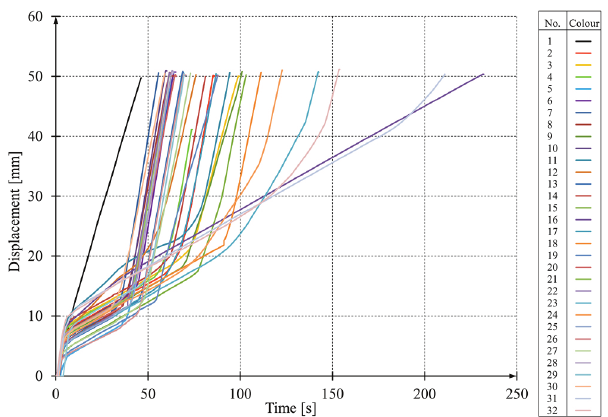
Fig. 17a. Pile head displacement change